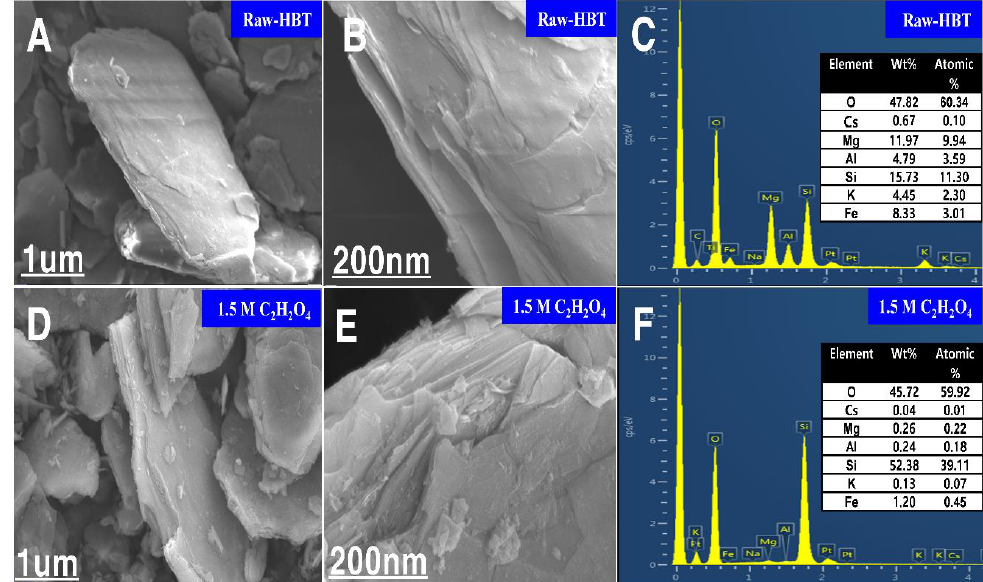
Figure 5. The results of scanning electron microscope (SEM)–energy dispersive spectroscopy (EDS) analysis of the solid sample after the desorption experiment. The SEM imaging shows: ( a , b ) Raw-HBT; ( d , e ) after 1.5 M oxalic acid treatment. ( c ) and ( f ) are the EDS-mapping.